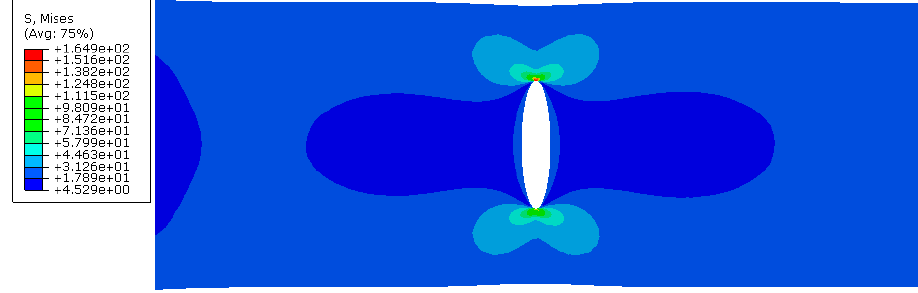
Figure 9. Distribution of stress in crack tip.